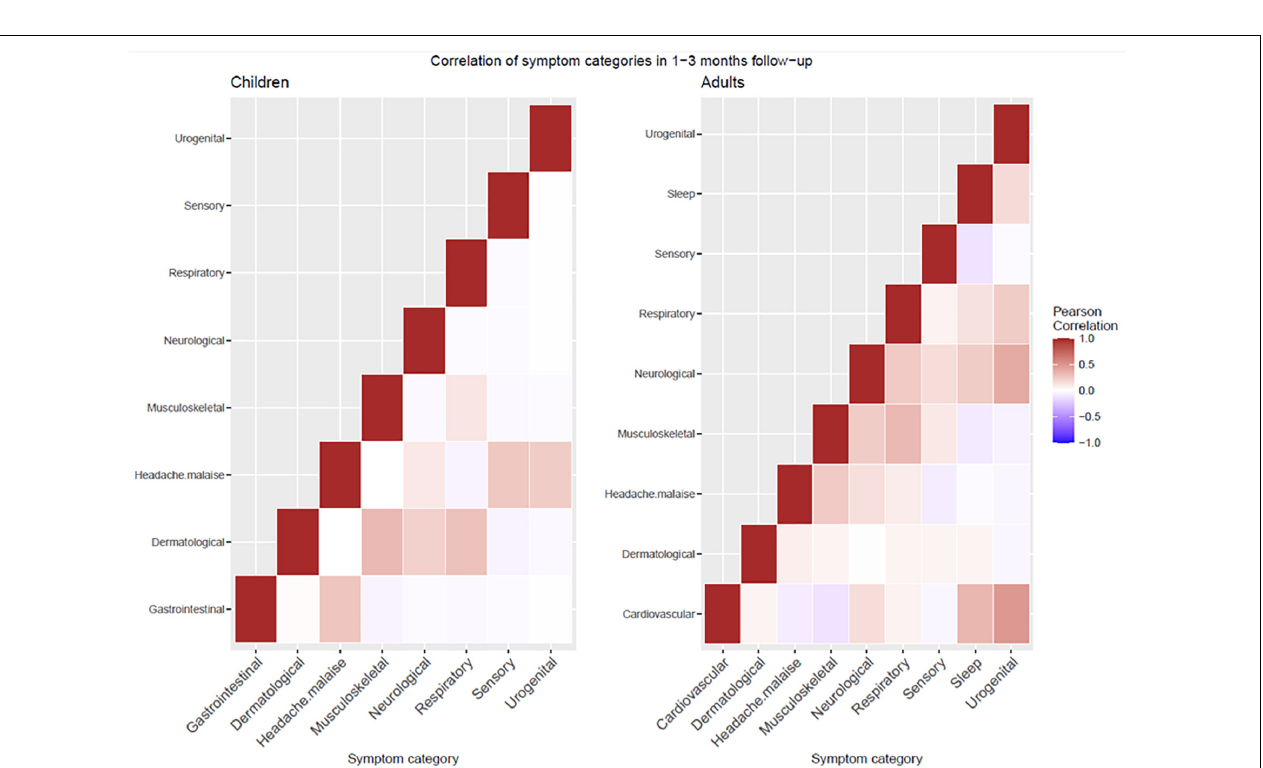
FIGURE 1 | Patterns of multisystem symptoms in adults (A,B) and children (C,D) at two different time points (1–3 months and 6–9 months follow-up), showing how many patients at each time points have more than one (and which one) symptoms simultaneously.